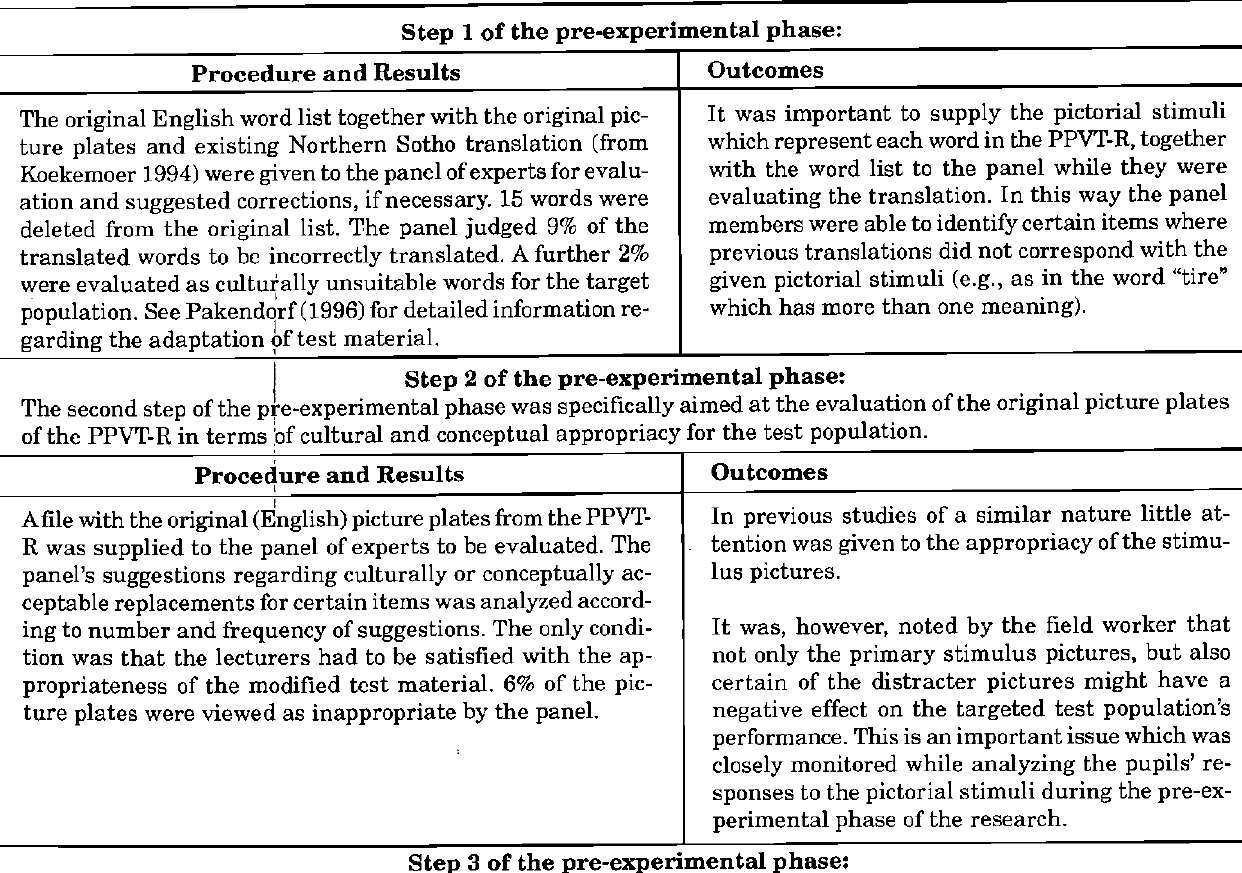
TABLE 1. Description of the Pre-experimental phase of the